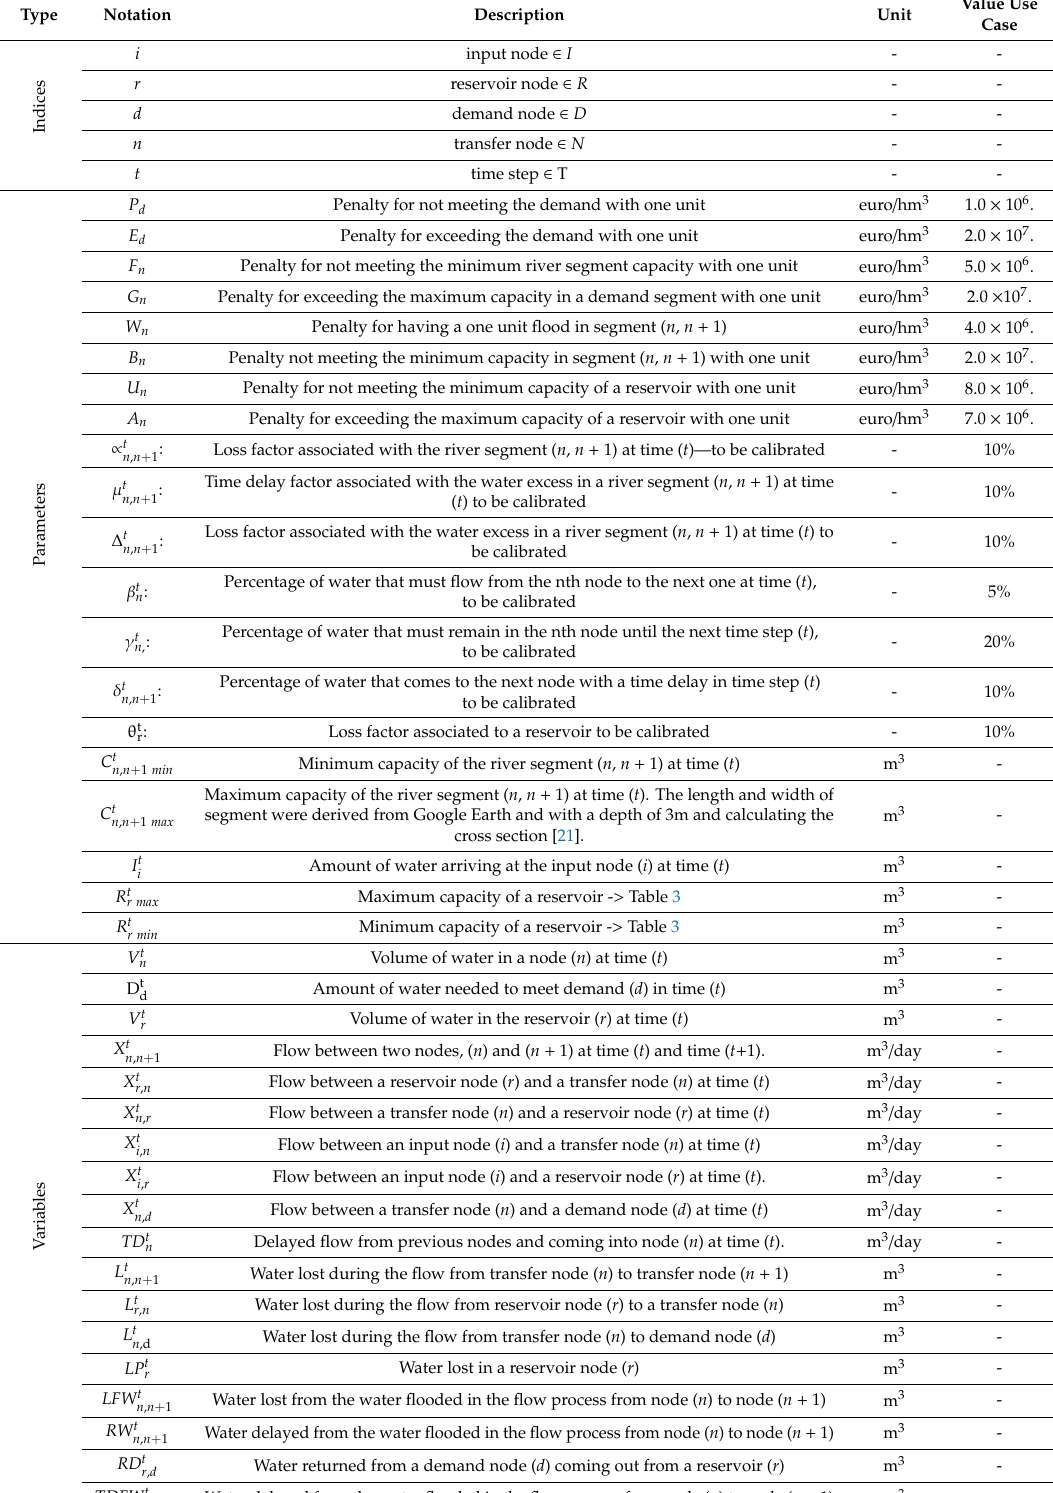
Table 3. Indices, parameters, variables, and slack variables with their assigned value for this case study and some of which are to be